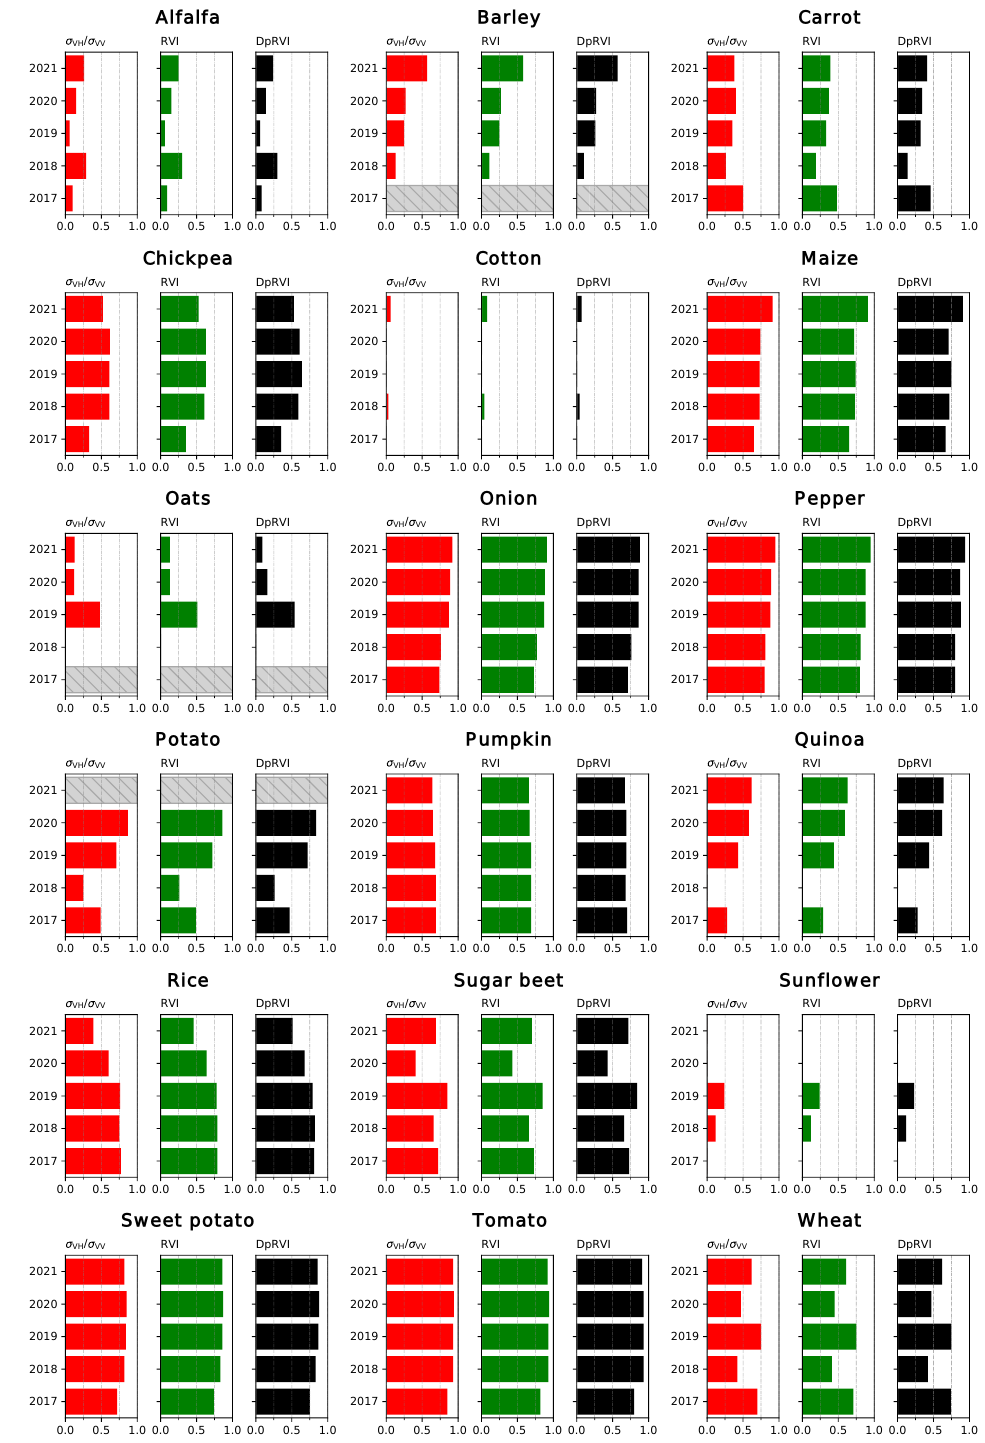
Figure 7. Coefficient of determination ( R 2 ) for the linear regressions between different radar VI and NDVI, restricting the series to the growing season. Years without data for a specific crop type are identified with a striped